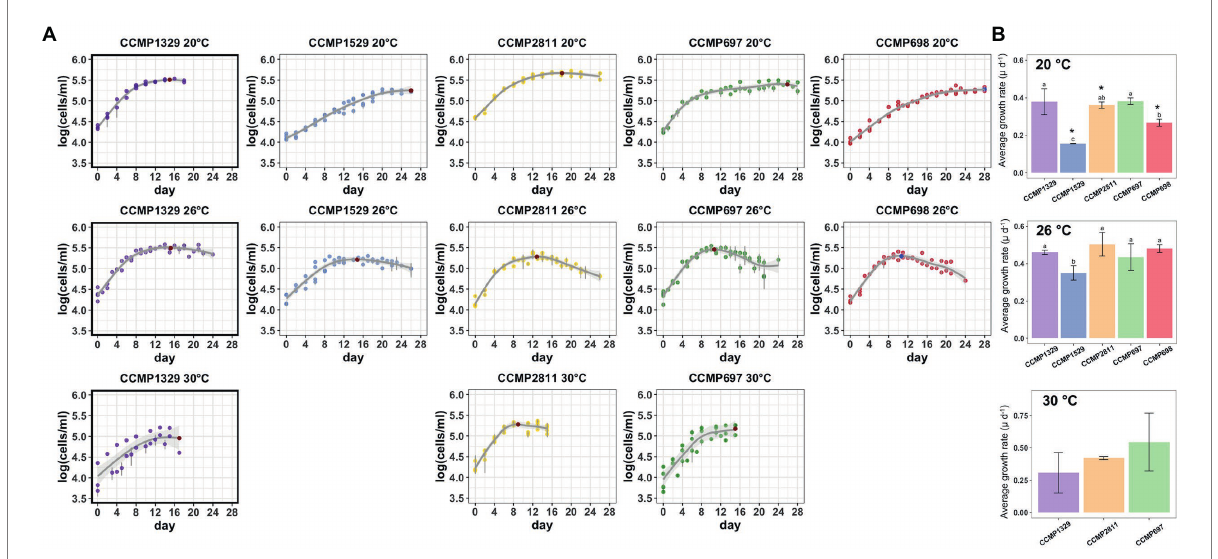
FIGURE 6 Growth of the five Prorocentrum cordatum strains at 20 ° C, 26 ° C, and 30 ° C. (A) Growth curves of each Prorocentrum cordatum strains at the different temperatures. Each point represents the average of triplicate cultures ± SD. Lines are from the best fitting GAM model quantifying the coupling between the logarithm of cell concentration as a function of time. (B) Growth rate barplots for each P. cordatum strain at each temperature. Values marked with different letters indicate statistically significant difference between the growth rate of strains for each temperature, while the (*) indicates significantly lower growth rate for that strain compared to 26 ° C ( p < 0.05), there was no significant change in growth between 20 ° C and 30 ° C.